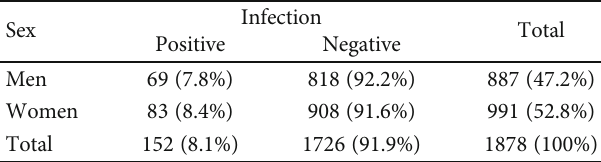
Table 1: The total number of men and women infected with Blatocystis spp.